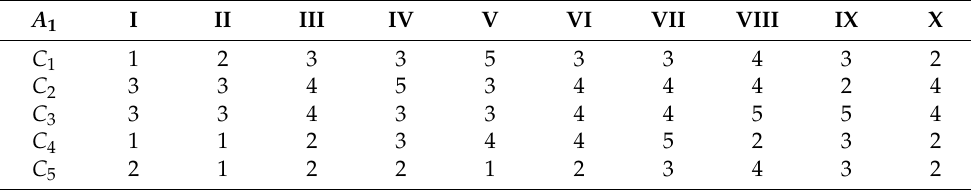
Table 2. Ratings of alternative A 1 in relation to the evaluation criteria obtained from 10 respondents.